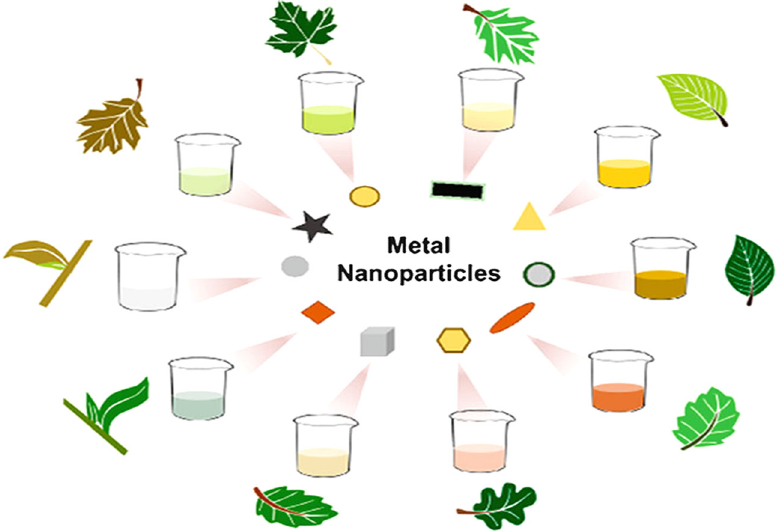
Figure 7: Green synthesis of MNPs using the extracts obtained from the leaves of di ff erent plant species leading to the production of structures with di ff erent compositions, shapes, and sizes [ 41 ]